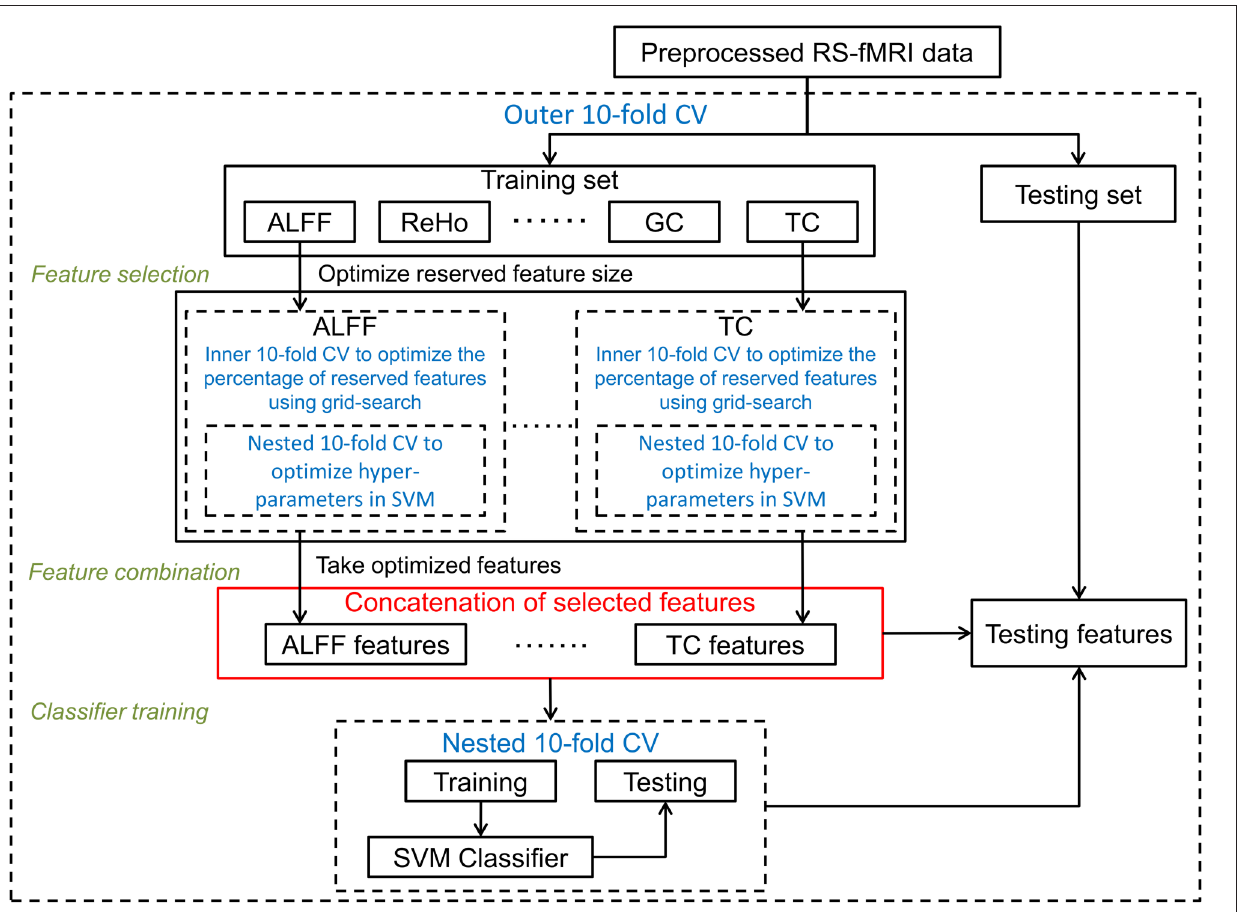
FIGURE 1 | Optimized framework of feature combination: after feature selection, optimized features were concatenated to serve the classifier training. Cross-validation parts are in blue font and dashed lines. To distinguish from the other two frameworks, the feature concatenation part is illustrated in red.